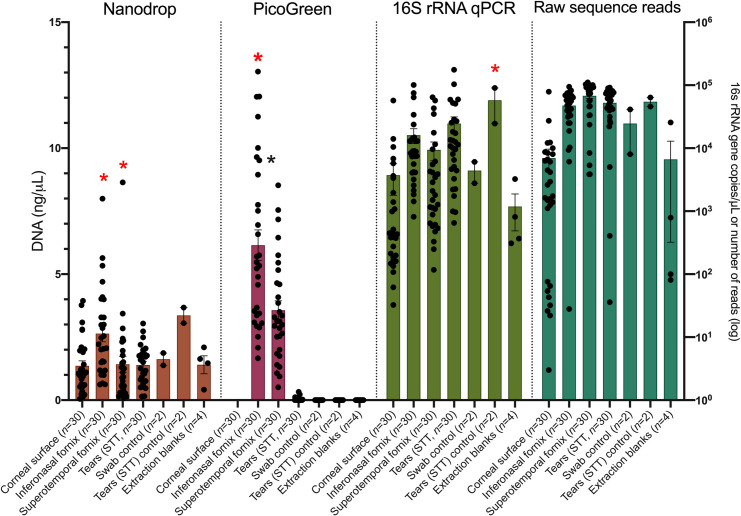
Amount of DNA per sample type according to different measurement methods and resulting raw reads (prior to removal of contaminants) yield.Stars denote statistically significant differences between a given sample type within each methodology (ANOVA followed by Bonferroni post-hoc test, P<0.05).